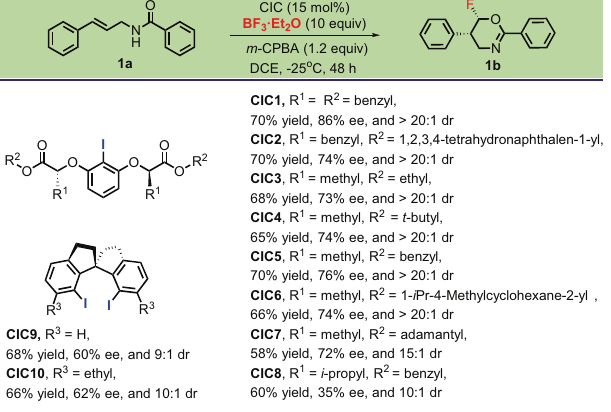
Fig. 2 Optimizing CIC structure in the model reaction. Notations for CICs: the reaction of 1a (0.1 mmol), BF 3 ·Et 2 O (1.0 mmol), m -CPBA (0.12 mmol) and catalyst (15% mol) was carried out in 4.0 ml of 1,2-dichloroethane (DCE) at − 25 °C for 48 h; isolated yields are reported. The ee values were determined by chiral HPLC analysis and the dr values were determined by 19 F